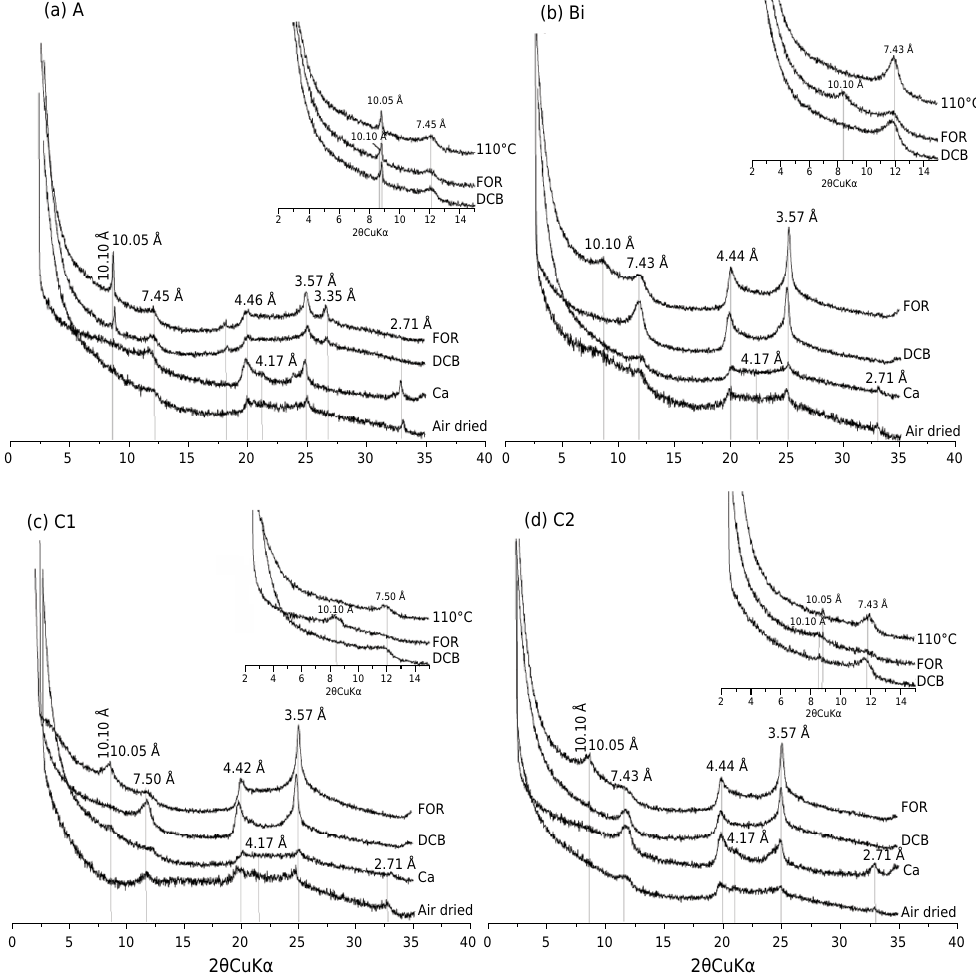
Figure 5. X-ray diffraction patterns of A (a), Bi (b), C1 (c), and C2 (d) horizons from P1 of clay fraction air dried, saturated with Ca 2+ (Ca), deferrified with sodium dithionite-citrate-bicarbonate (DCB) and saturated with formamide (FOR). Biotite: 10.10 Å; 3.35 Å; Halloysite: 10.05 Å; 7.45 Å, 4.46 Å, 3.57 Å; Hematite: 2.71